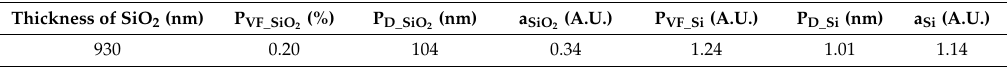
Table 1. Results of the model’s variables obtained from the inverse-modeling procedure. Thickness of SiO 2